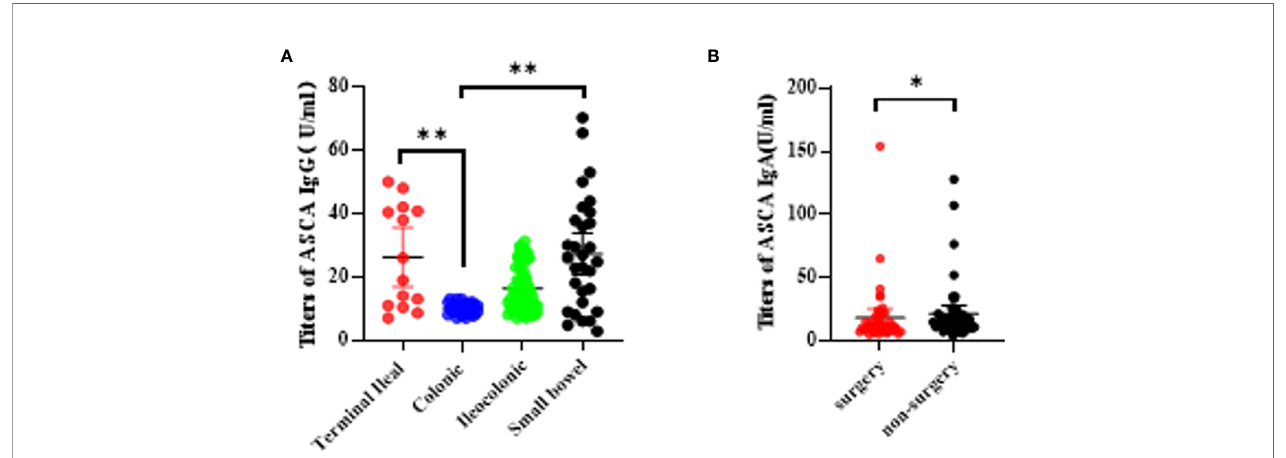
FIGURE 3 | Association betweeen serological markers and the disease phenotype during the disease course in CD patients. (A) The titers of ASCA IgG in disease location (*P < 0.05, **P < 0.0001); (B) The titers of AMCA in disease related surgery (P =